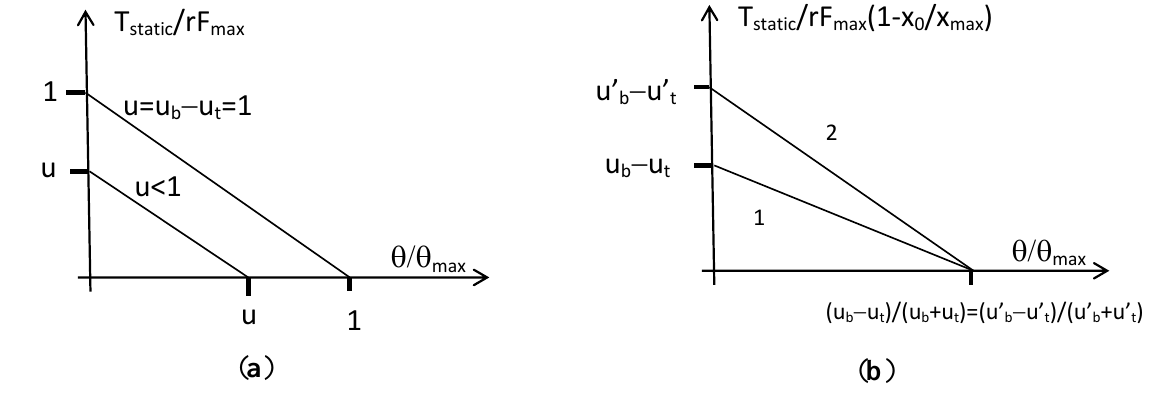
Figure 7. Torque-angle characteristics for the constant moment arm antagonist actuator, ( a ) the case of two identical linear artificial muscles, and ( b ) the case of two identical biomimetic artificial muscles showing the ability of the actuator to modify its angular stiffness (from slope 1 to 2, for example, by increasing the sum of agonist and antagonist control values) while keeping the same equilibrium position (for simplicity reasons we limited our graphs to positive angle and torque).